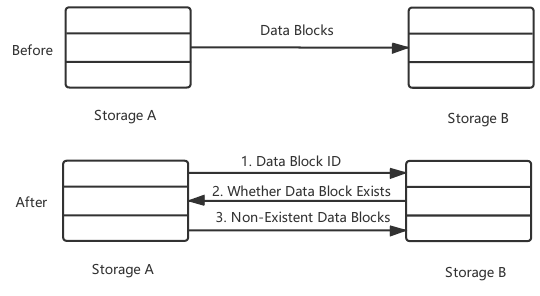
Fig. 4. The data flow before and after using deduplication